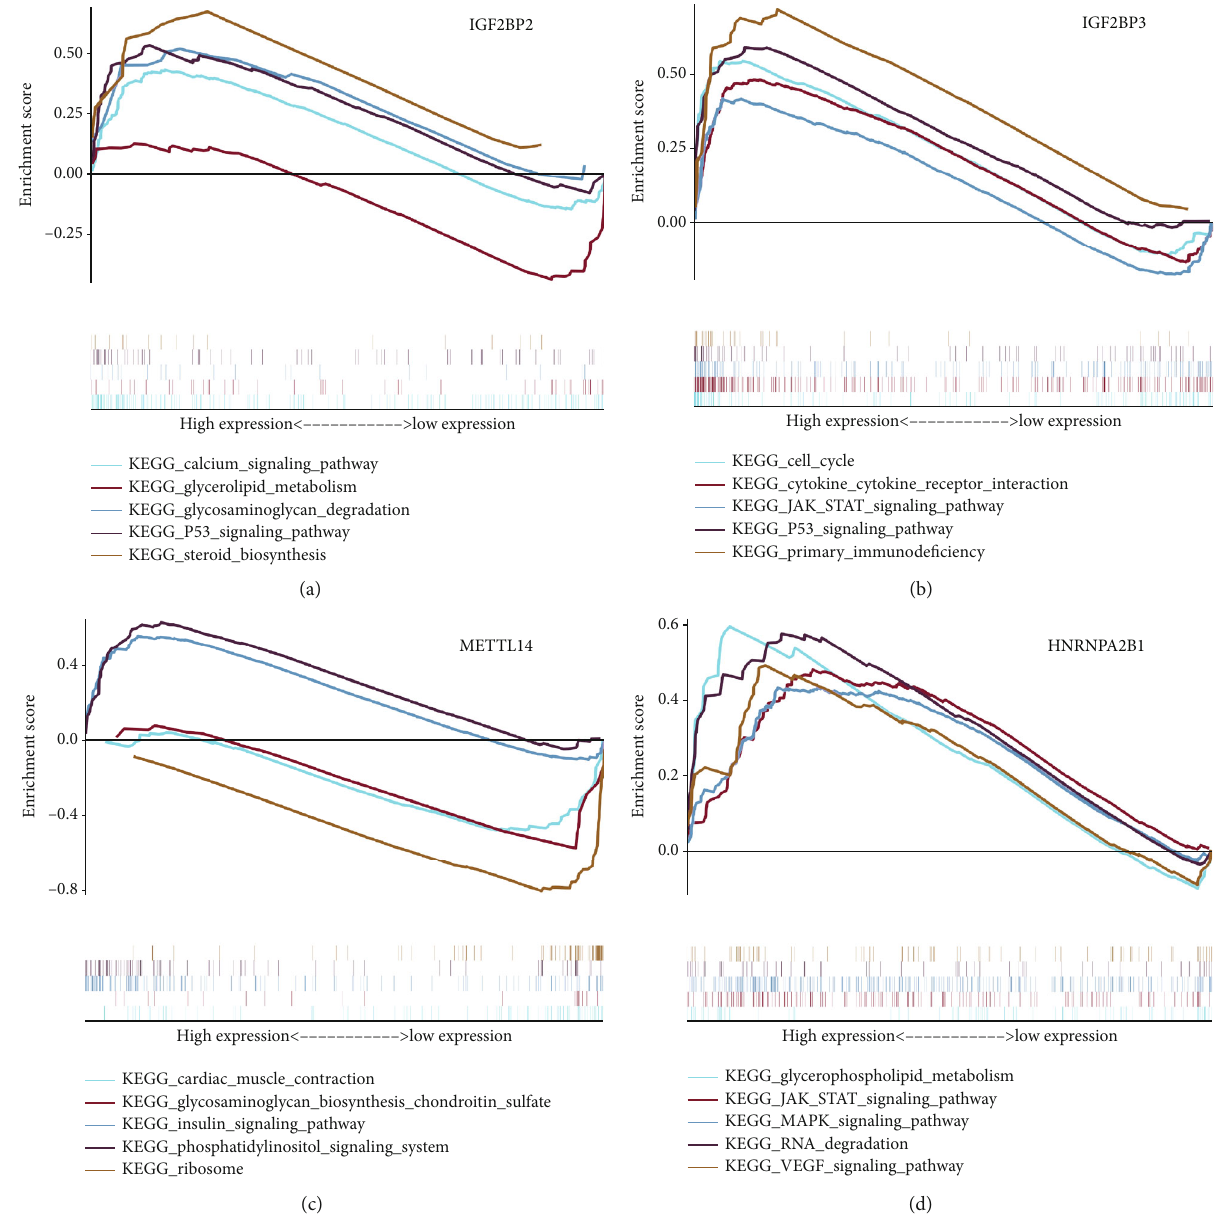
Figure 9: GSEA pathway analysis of IGF2BP3, IGF2BP2, HNRNPA2B1, and METTL14 genes. (a – d) An upward parabola indicates that the indicated gene promotes the pointed pathway; otherwise, the pathway is